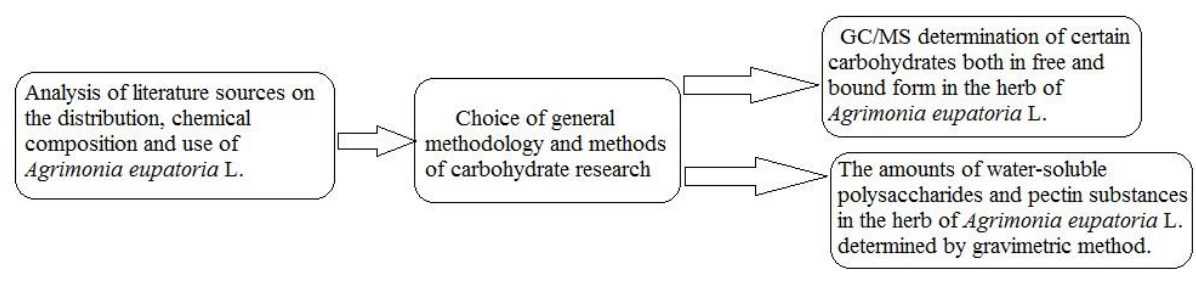
Fig. 1. Design of the experiment